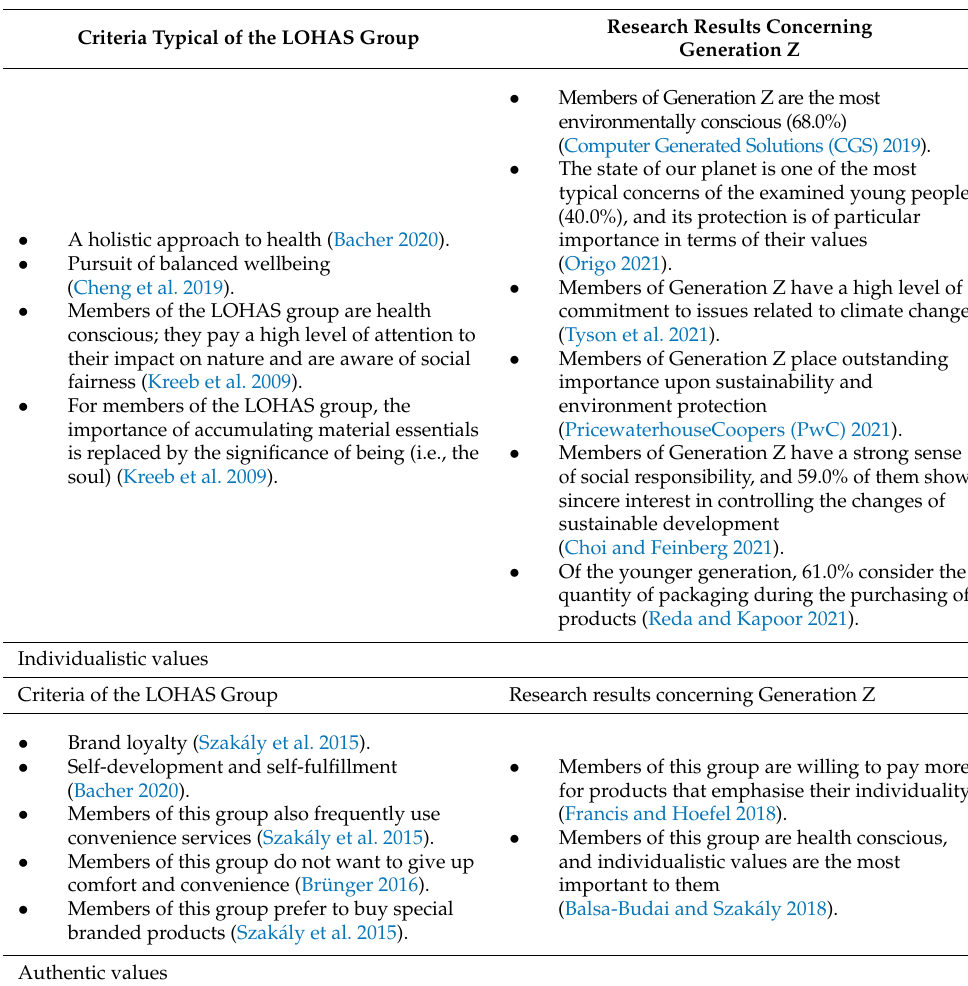
Table 1. Consumer criteria and preferences in accordance with the LOHAS